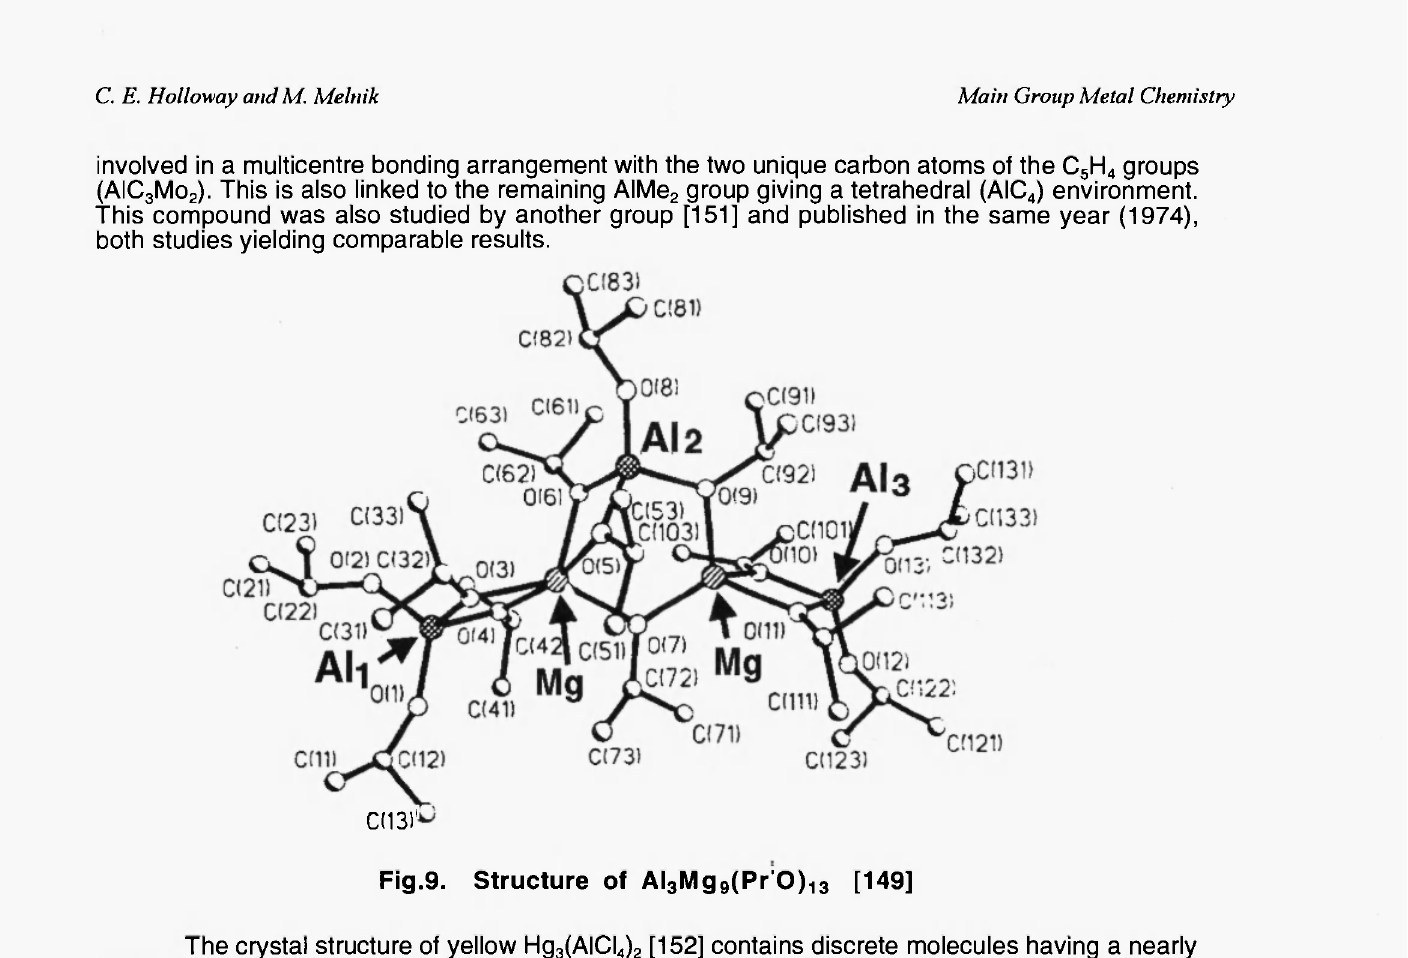
Fig.9. Structure of AI 3 Mg 9 (PrO)